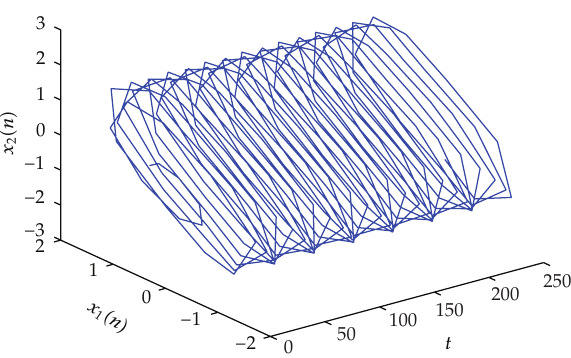
Figure 8: An invariant closed circle bifurcates from equilibrium (cid:2) 0 , 0 (cid:3) . The initial value and parameter D are (cid:2) 2 , 3 (cid:3) and 14 / 3,